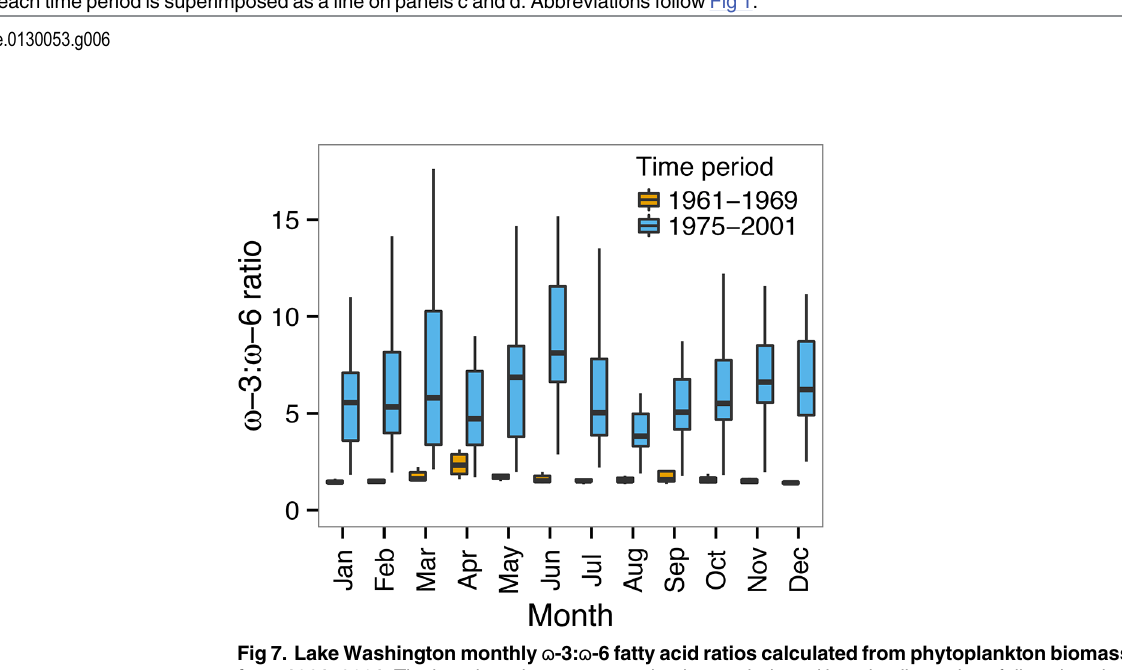
PLOS ONE | DOI:10.1371/journal.pone.0130053 June 15, 2015 13 /